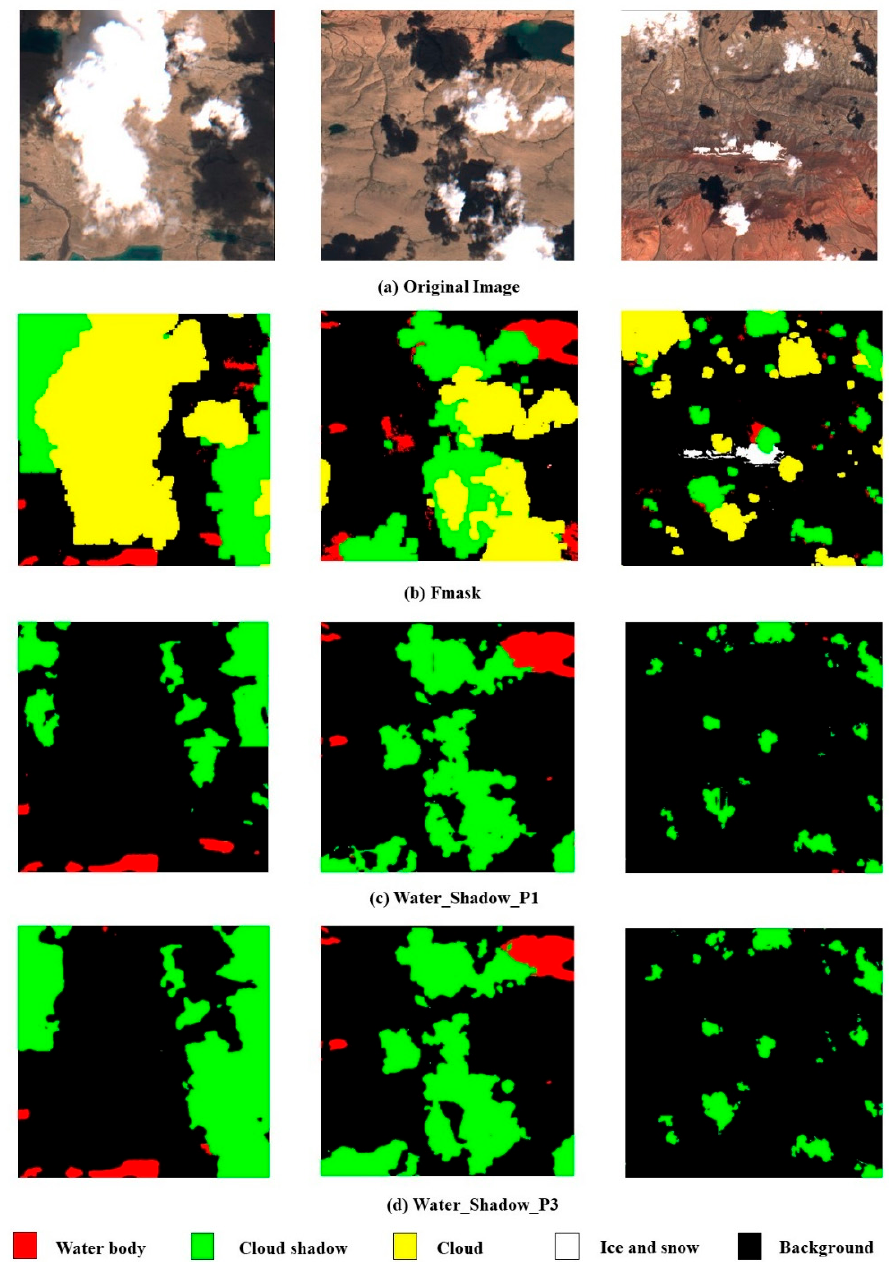
Figure 8. Results of cloud shadow extraction.